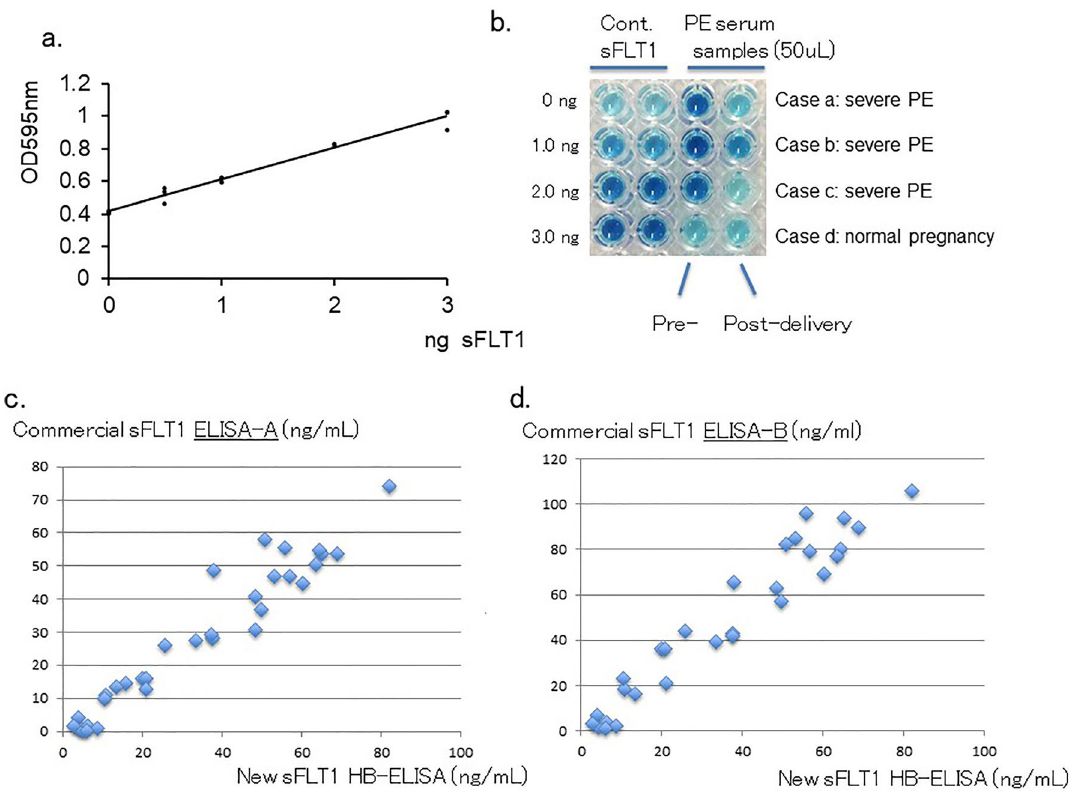
Figure 2. New sFLT1 assay system HB-ELISA detects similar levels of sFLT1 with those detected by commercially available recent sFLT1 ELISA kits. ( a ) A standard curve for sFLT1 assay. 0.5, 1.0, 2.0 and 3.0 soluble FLT1 (7 N FLT1) were assayed with this HB-ELISA three times for each. ( b ) a HB-ELISA assay for the serum samples from 3 severe-PE patients and one normal pregnancy. ( c , d ) Comparison of the sFLT1 values between the HB-ELISA and two commercially available recent ELISA kits. The sFLT1 values in the vertical axis were detected with commercial sFLT1 ELISA-A ( c ), and with ELISA-B ( d ). sFLT1 values in the horizontal axis ( c , d ) were detected with sFLT1 new HB-ELISA.